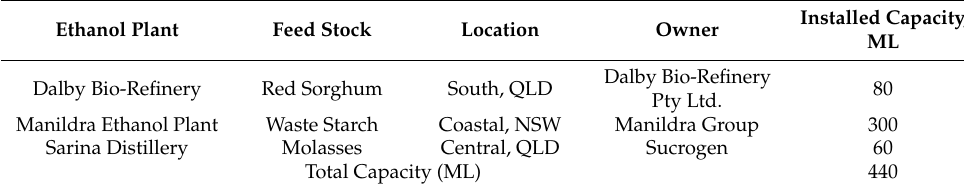
Table 8. Ethanol plants in Australia